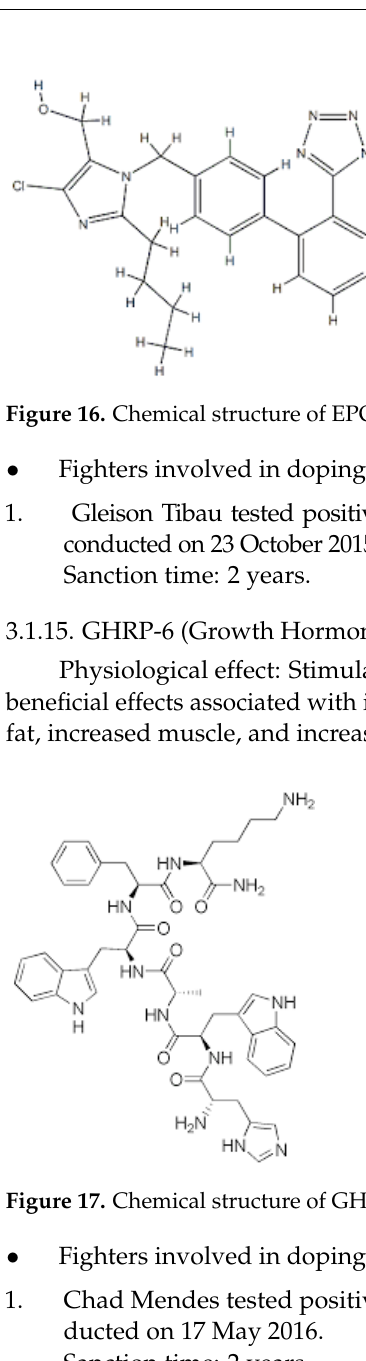
Figure 18. Chemical structure of GHRP-2. Formula: C 45 H 55 N 9 O 6. Physiological effect: Stimulate secretion of growth hormone [25]. It has a number of beneficial effects associated with increased growth hormone levels, such as decreased body fat, increased muscle, and increased strength and endurance. • Fighters involved in doping with GHRP-6.